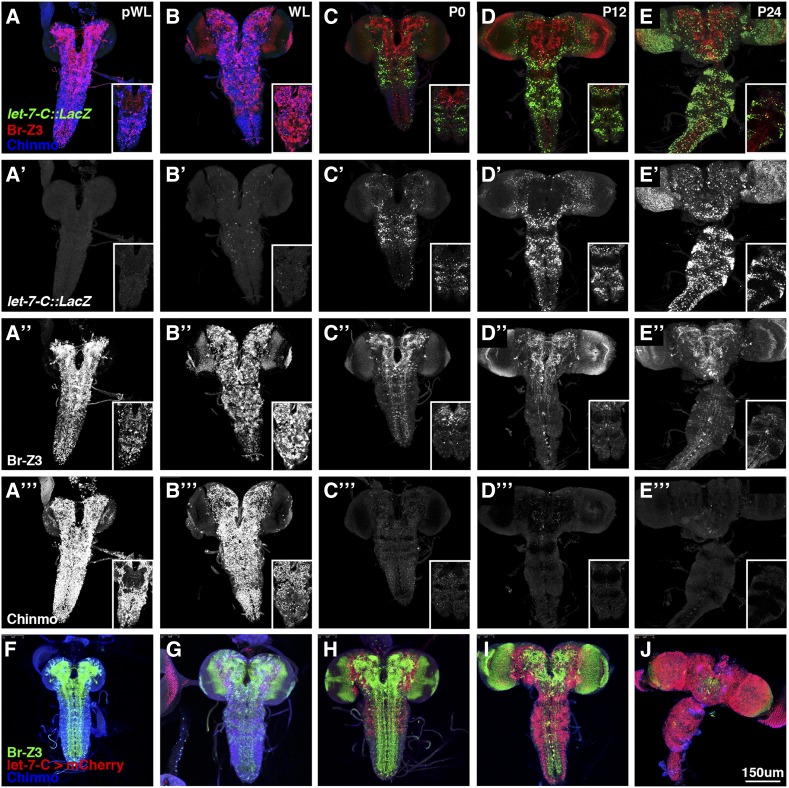
let-7-C expression inversely correlates with Br-Z3 and Chinmo expression in the CNS during the larval-to-pupal transition. (A-E). Dissected CNS from (A) pre-wandering larva (pWL), (B) wandering larva (WL), (C) white prepupa (P0), (D)12 hr-old pupa (12hr), and (E) 24 hr-old pupa (P24) stained for let-7-Cp12.5kb::lacZ transcriptional reporter (green in A-E, white in A’-E’), Br-Z3 (red in A-E, white in A’’-E’’) and Chinmo (blue in A-E, white in A’’’-E’’’). Insets: single confocal sections of the VNC at each timepoint. (F-J) Dissected CNS from (F) pre-wandering larva (pWL), (G) wandering larva (WL), (H) white prepupa (P0), (I)12 hr-old pupa (12hr), and (J) 24 hr-old pupa (P24) stained for let-7-CΔ3miR::optGal4 > mcherry (red), Br-Z3 (green) and Chinmo (blue). Scale bars: A-J, 150µm.